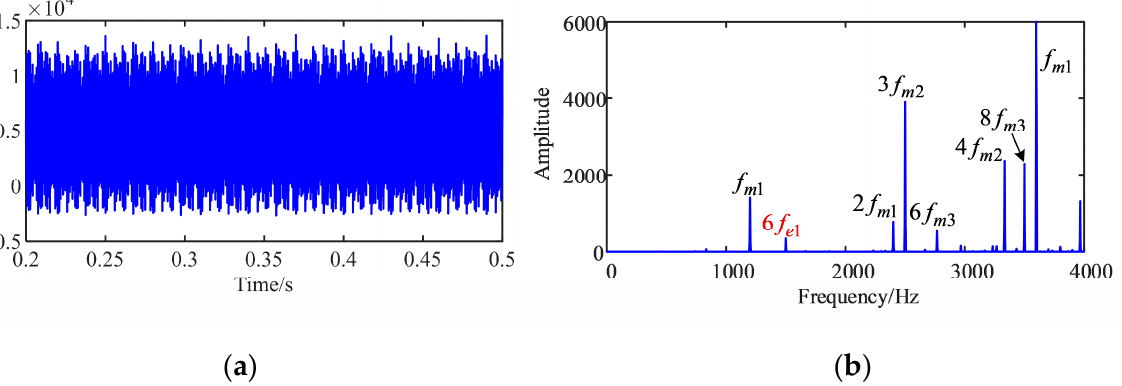
Figure 11. The meshing force of the first gear pair in the single-motor drive mode: ( a ) time domain; ( b ) PSD.